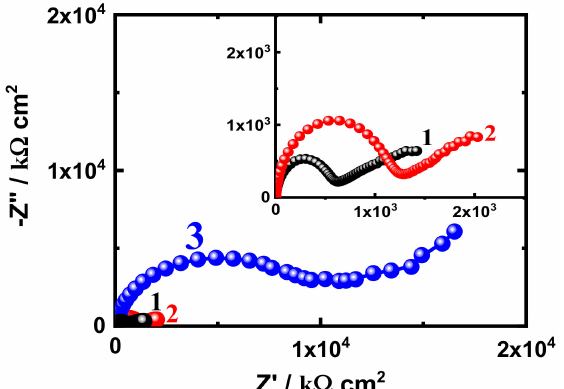
Figure 10. Nyquist plots obtained for (1) SN1, (2) SN3, and (3) SN5 after their immersion for 25 days in 3.5% NaCl solutions.